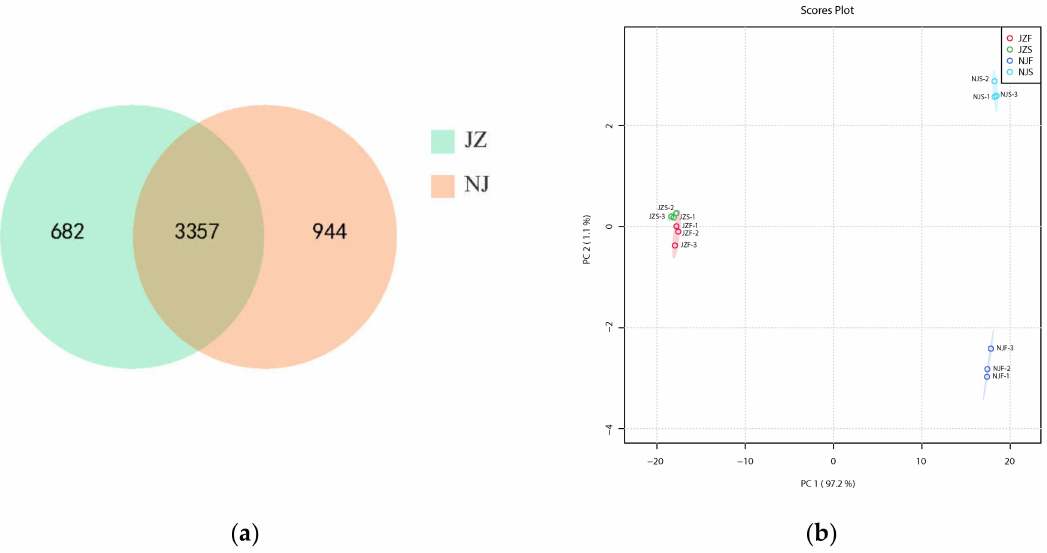
Figure 2. The protein variation between different varieties. ( a ) Venn plot; ( b ) PCA of protein profiles.